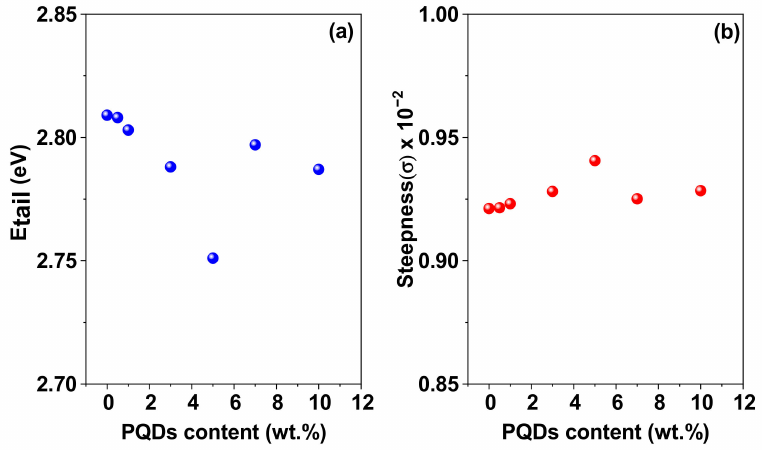
Figure 6. ( a ) Variations in the Urbach energy ( E u ) and ( b ) the steepness parameter of the MEH − PPV/PFO hybrid, CsPbBr 3 − PQDs, and PQDs/(MEH − PPV/PFO) composite thin-films as a function of the PQDs content. The solid lines represent data −